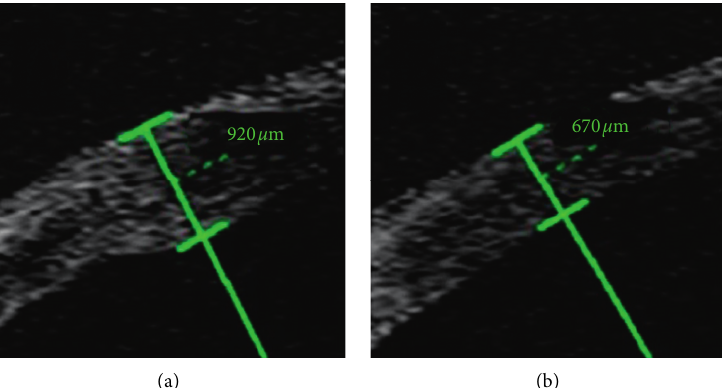
Figure 5: Representative anterior segment optical coherence tomography images showing corneal thickness measurements at the incision site at 1 week (a) and 3 months (b)